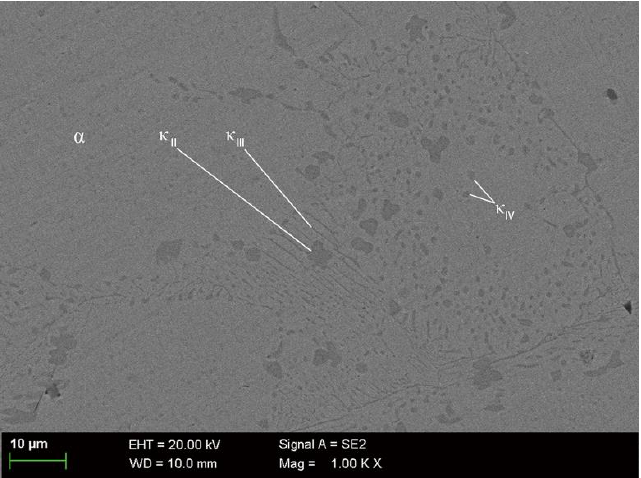
Figure 4. The microstructure of S-Cast before corrosion.